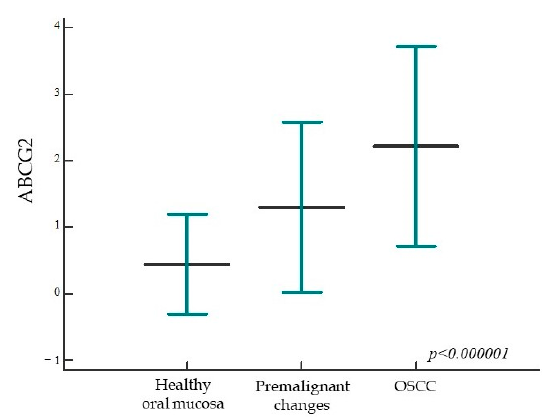
Figure 7. ABCG2 protein expression in the studied groups. The percentage of ABCG2 expression is significantly higher in the group of patients with premalignant changes and OSCC compared to subjects with healthy oral mucosa; moreover, a statistically significant difference was found between all studied groups ( p < 0.000001). Horizontal lines indicate mean ± standard deviation; p , significance level is marked on Kruskal-Wallis graph. Int. J. Mol. Sci. 2023 , 24 , x FOR PEER REVIEW